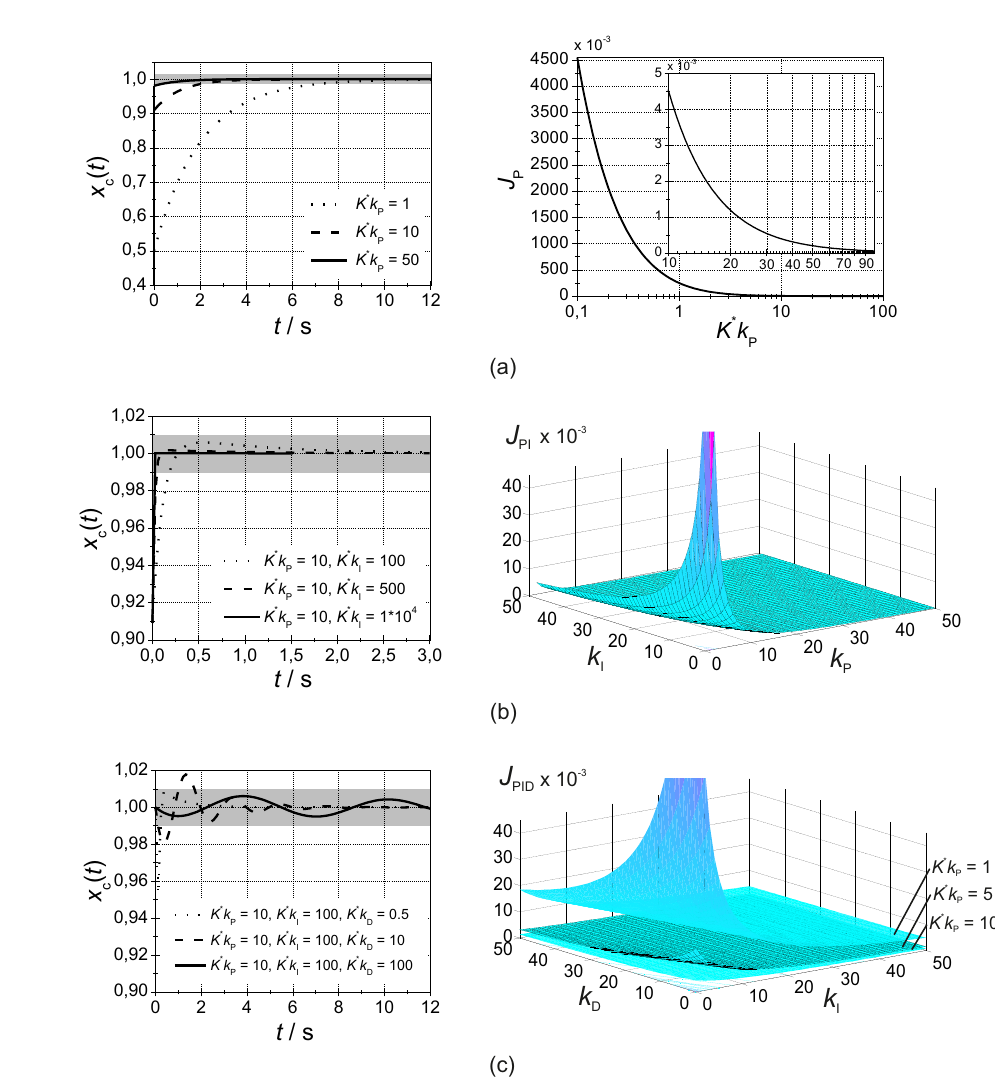
Figure 14. Step response of the closed-loop sensor for selected controller parameters (left) and ISE performance index as a function of the respective controller parameter (all other parameters are fixed) (right) for a (a) P-controller, (b) PI-controller, and (c) PID-controller. The light gray region indicates a tolerance band of ± 1% of the steady state value. For all graphs a drift rate of δ = 1 s − 1 was